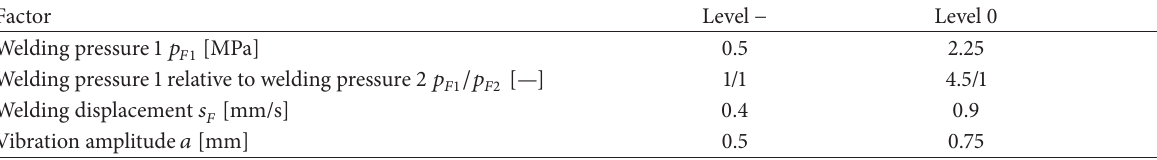
Table 5: Variation of welding parameters in vibration welding.